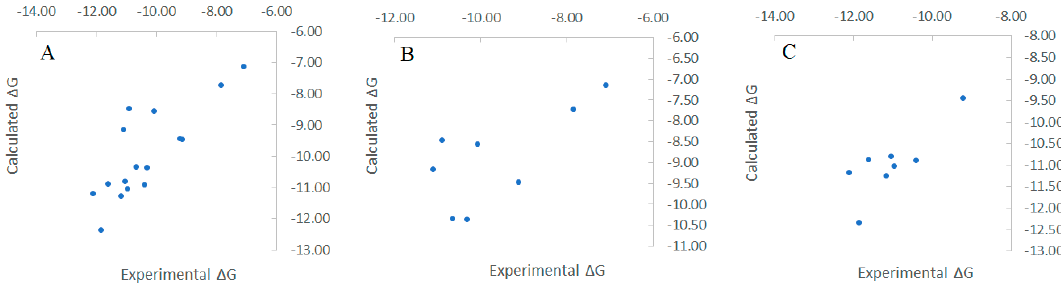
Figure 2. Scattered plots comparing the binding free energy calculated by Moveable Type to experimental data for the caspase-3-Inhibitor test set. ( A ) All the test cases. ( B ) small molecule inhibitors sub-group. ( C ) peptidomimetic inhibitor sub-group.